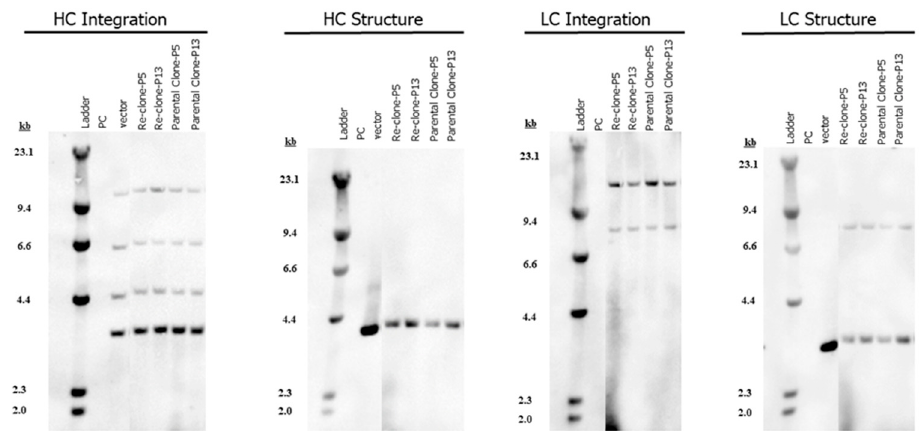
Figure 5. mAb2 genetic integration and structure analysis for the parental clone and re-clone. South- ern blot analysis was used to determine the structural and integration profiles of the target HC and LC genes.